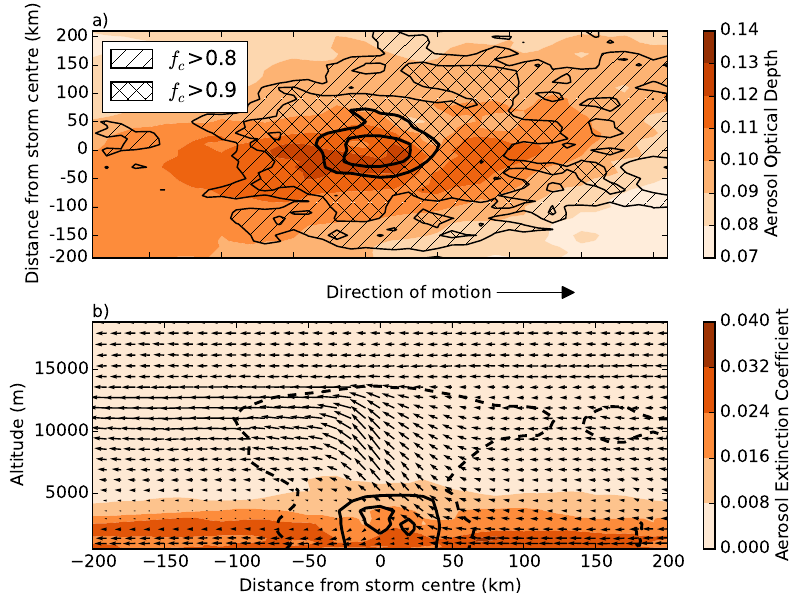
Figure 6. As Fig. 5 but constructed from a simulation with no wet scavenging of aerosol. This composite is composed of 22 individual convective